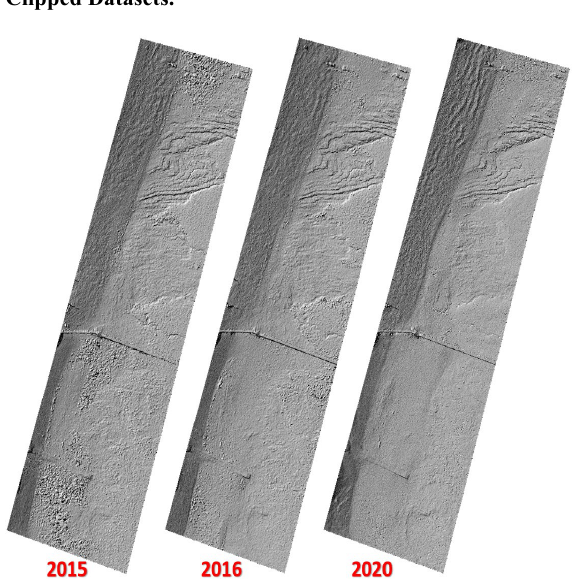
Figure 11 – UAV Hill-Shaded Relief Models of the 2015, 2016 and 2020 Clipped Datasets.